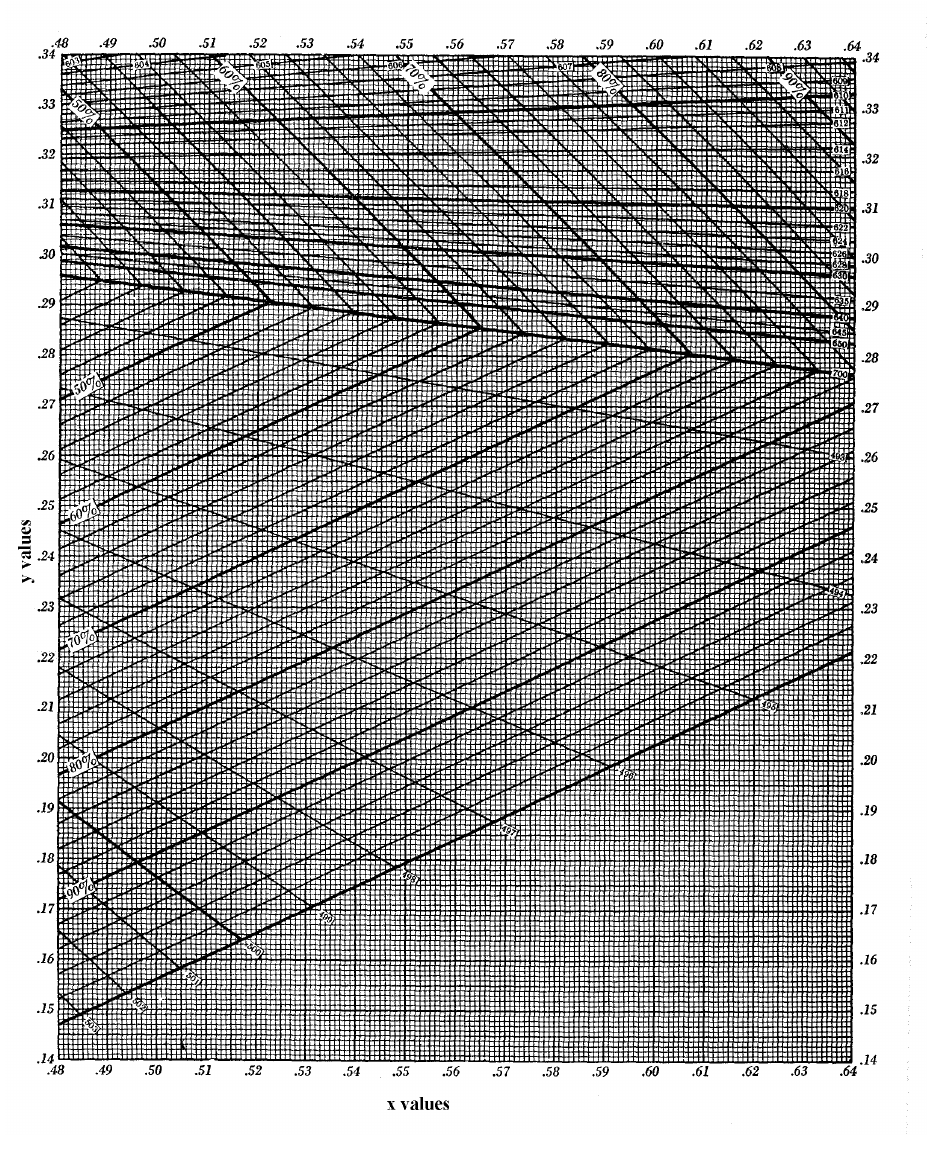
Chromaticity diagram for pure red wines and purple